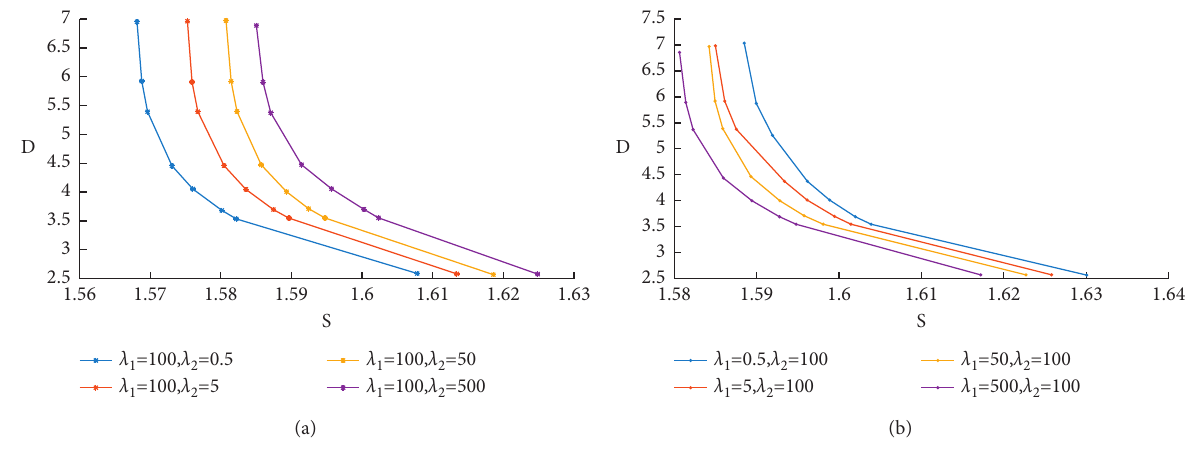
Figure 2: L-curves of different parameters α , λ